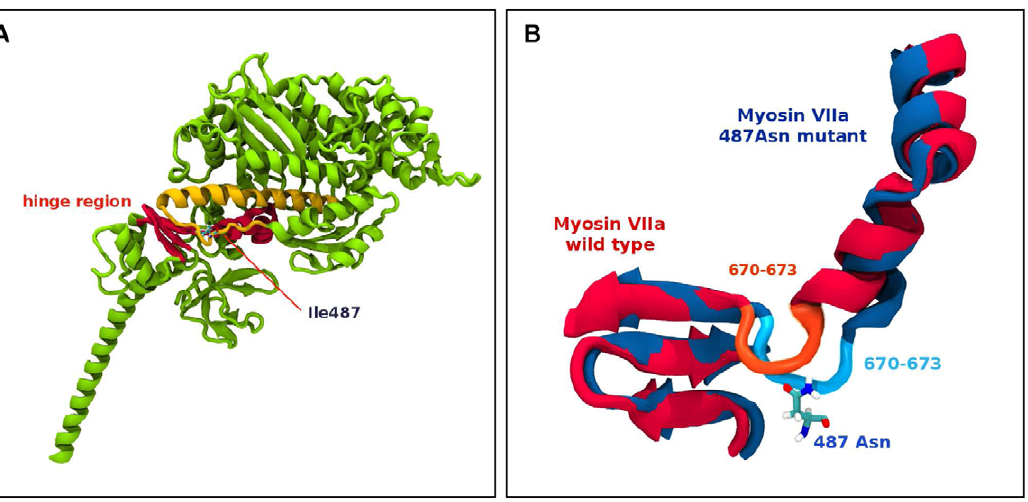
Figure 3. Molecular modelling of the Myo7a I487N/I487N ewaso mutation. ( A ) Partial ribbon representation of a 3D model of myosin V 2DFS highlighting the Ile 487 amino acid residue, which is localised to the hinge region between the head and tail domains of the protein. ( B ) Schematic diagram showing superimposed images of the hinge region ( Myo7a + / + in red and the Myo7a I487N/I487N ewaso mutation in blue) after 4 ns of molecular dynamics simulation showing a conformational change in the hinge region close to the Ile 487 mutation site, showing the involvement of residues 670–673 around the hinge region causing the distortion.